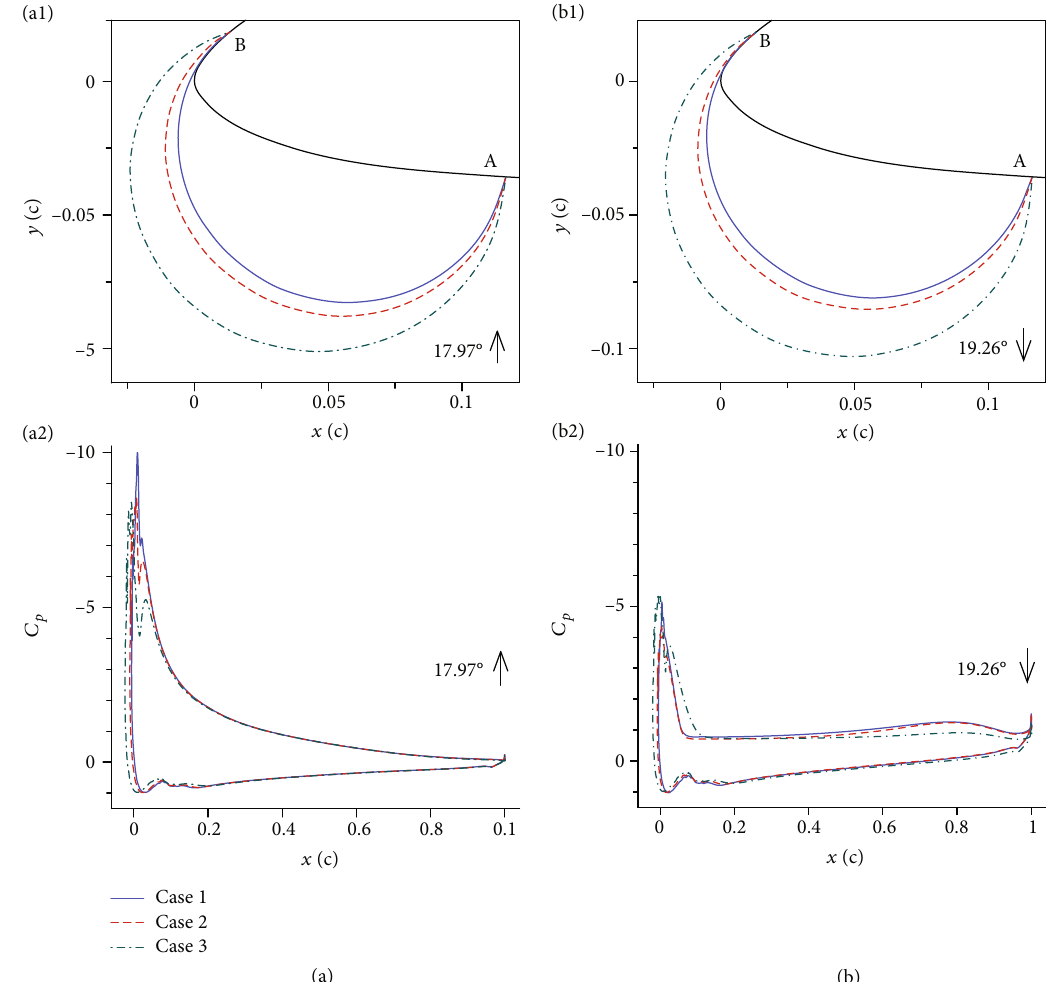
Figure 20: The ILE shapes and pressure coe ffi cient distributions at di ff erent angles of attack for Cases 1, 2, and 3.